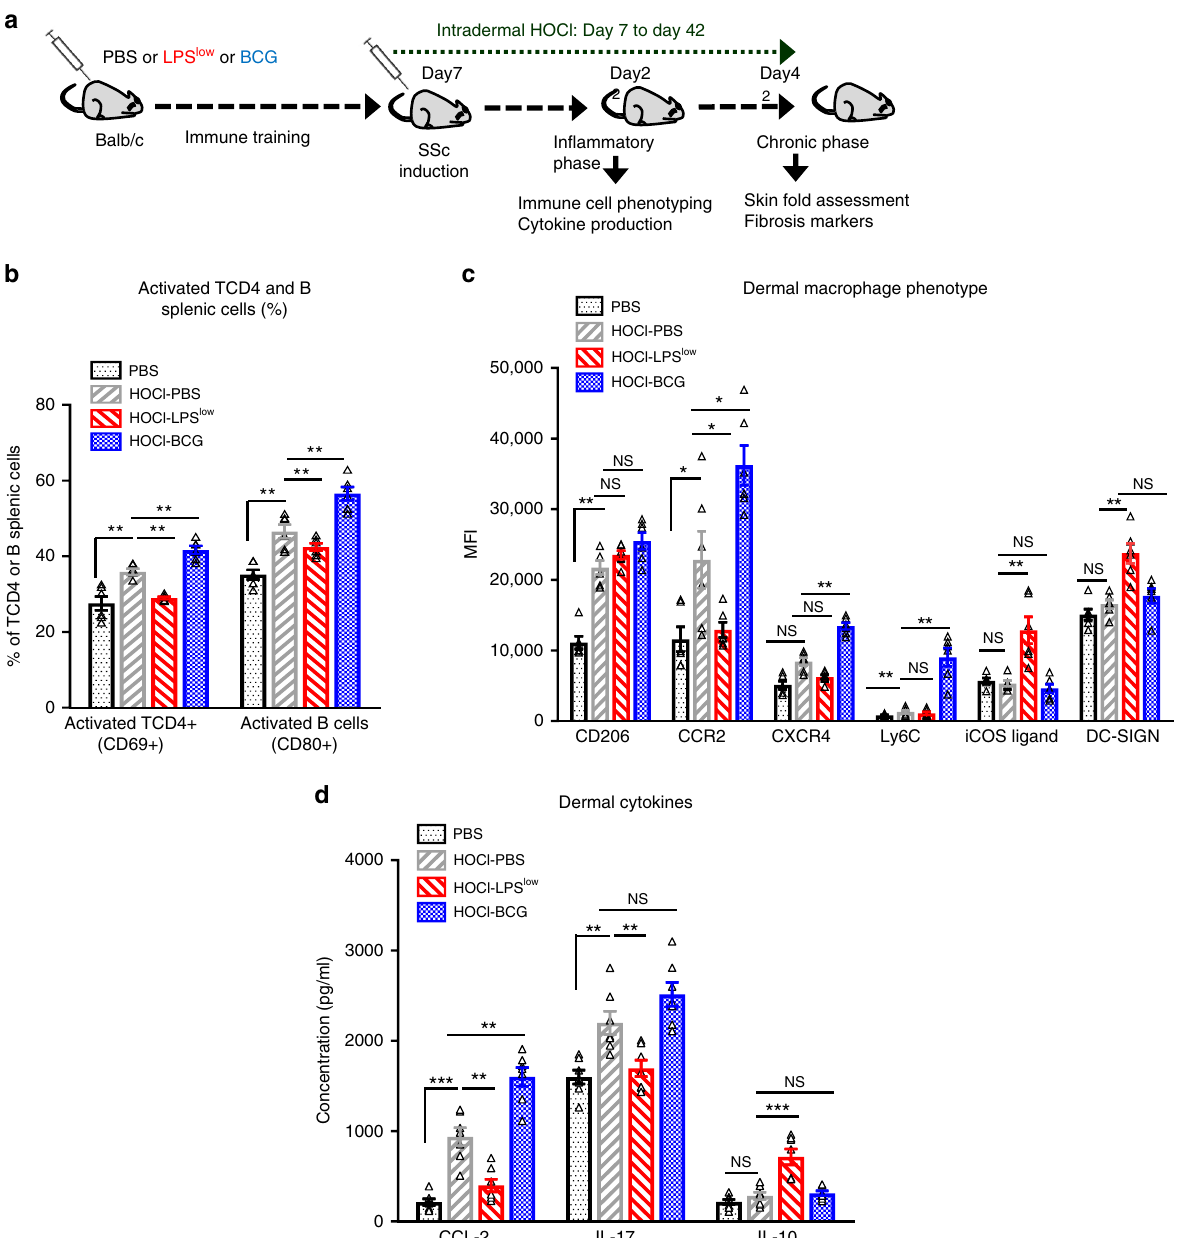
Fig. 2 Trained immunity modulates in fl ammation in HOCl-induced SSc. a Schematic representation of the experimental induction of fi brosis in trained mice. Mice ( n = 12 per group) were trained either by LPS low , BCG, or PBS and then injected intradermally from day 8 to day 42 with HOCl. The control group (PBS mice) was injected daily with sterile PBS for 6 weeks. At day 22 of the experiment (Acute in fl ammatory phase), 7 animals per group were euthanized to perform immune cell phenotyping and cytokine production assessment. The remaining animals ( n = 5 per group) were euthanized at day 42 (Chronic fi brotic phase) to perform fi brosis markers assessment. b Flow cytometric characterization of splenic B cells and CD4 + T cells at day 22. Data represent the absolute count for T CD4 + and B cells and percentage of activated B cells (Expression of CD80) and CD4 + T cells (Expression of CD69) with SEM from n = 5 biologically independent samples. c Flow cytometric analysis of dermal macrophage phenotype at day 22. Dermal macrophages were gated on CD11b and F4/80 positive cells among CD45 positive. Data represent the mean fl uorescence index (MFI) and SEM from n = 7 biologically independent mice. d Cytokine production (pg/ml) in dermal culture supernatant (ELISA assessment). Each box represents mean ± SEM of triplicate obtained with cell culture from n = 7 biologically independent mice. Statistics are shown between PBS and HOCl-PBS groups fi rst and then treated groups (LPS low and BCG) versus HOCl-PBS group. The ANOVA test with Bonferroni correction was used to detect signi fi cant differences between the groups. NS: Non signi fi cant; * p ≤ 0.05; ** p ≤ 0.01; *** p ≤ 0.001. Source data are provided as a Source Data fi the therapeutic potential of a cellular therapy based on a weekly progression of skin thickening compared to the controls in vitro trained BMDM injection on HOCl-mice (Fig. 5a). Peri- while treatment with BCG- macrophages accelerated it (Fig. 5b). toneal injections of PBS-trained macrophages did not impact the Collagen content in skin was elevated in mice injected with BCG- skin thickening in HOCl-mice (considered as controls in this macrophages and reduced in animals treated with LPS low -mac- rophages when compared to HOCl-mice (Fig. 5c). A similar trend experiment). Injection of LPS low -macrophages induced a slower